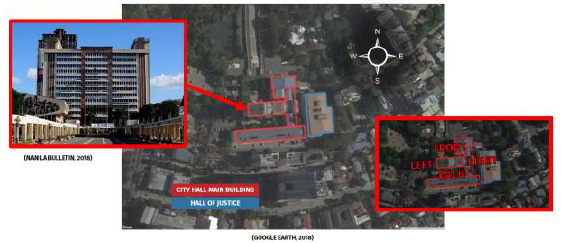
Figure 1. Google Earth Screenshot of Buildings in Area of